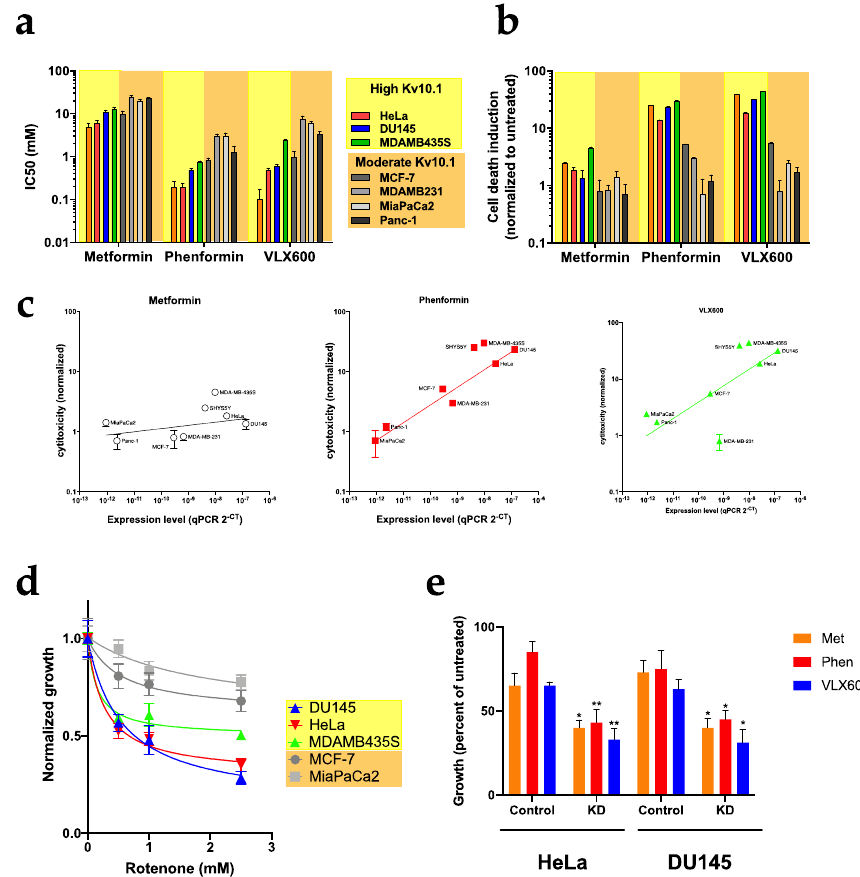
Figure 9. Cell lines with overexpression of Kv10.1 show high sensitivity to metabolic drugs. ( a ) IC50 of the metabolic drugs on the growth of the indicated cell lines measured as confluence using phase contrast in a Incucyte live cell imaging system. ( b ) Cellular toxicity in the di ff erent cell lines treated with metabolic inhibitors. Cells were labeled with Cytogreen to detect death cells. ( c ) Correlation of cytotoxicity with expression level of Kv10.1 in the di ff erent cell lines. The normalized cytotoxicity was plotted against the threshold values for Kv10.1 in RT-PCR. ( d ) The growth of the indicated cell lines in the presence of di ff erent concentrations of rotenone was determined and is presented normalized to the growth in untreated cells. Cell lines with high Kv10.1 expression were more sensitive than those with low levels. ( e ) HeLa and DU145 cells were transfected with siRNA for Kv10.1 for 48 h and treated with the IC50 of the di ff erent metabolic inhibitors. Bars represent the mean ± SEM of three independent experiments (* p < 0.05; ** p < 0.01, two-way